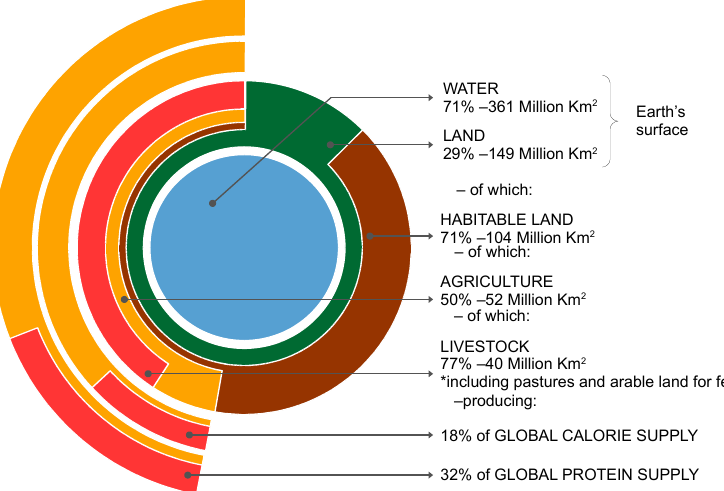
Figure 4. Land use per caloric outputs of animal farming as share of total—authors’ adaptation after [50]. * The land used for livestock includes farms, buildings and pastures and land for feed, not only the physical land occupied with animals.